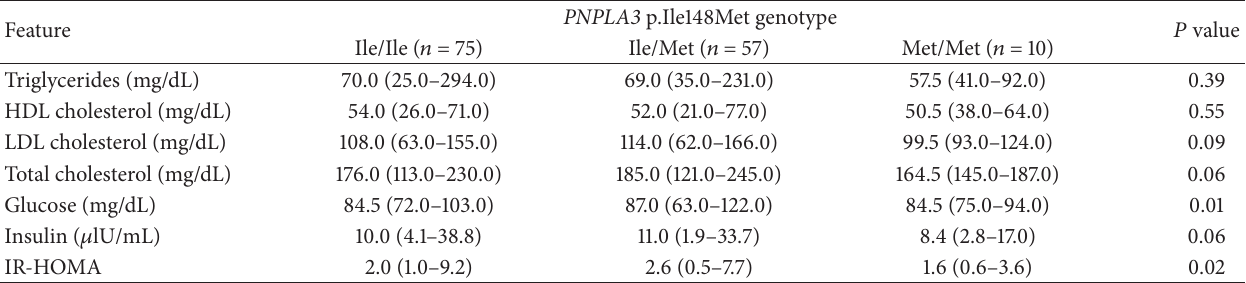
Table 2: Metabolic traits in relation to the PNPLA3 p.Ile148Met